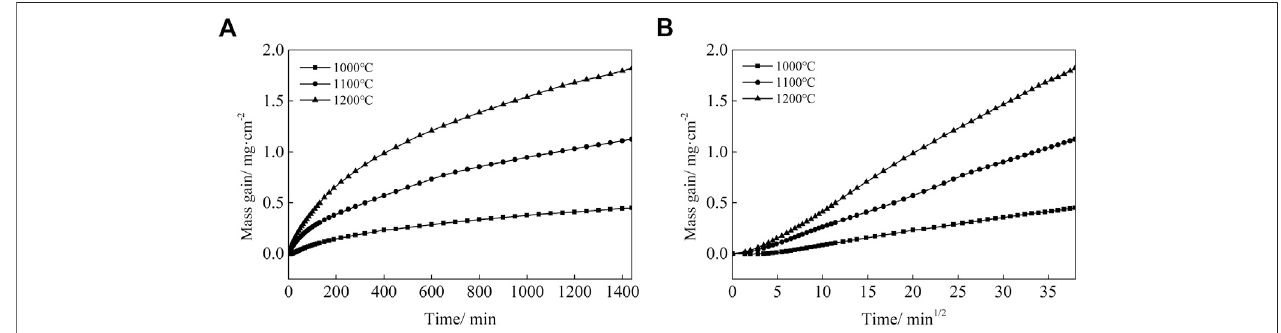
FIGURE2| Oxidationkinetics (A) and correspondingparabolic plots (B) for theCo-20Re-25Cr-3Si alloys under0.1 MPalaboratoryair at1,000 – 1,200 ° Cfor24 h.